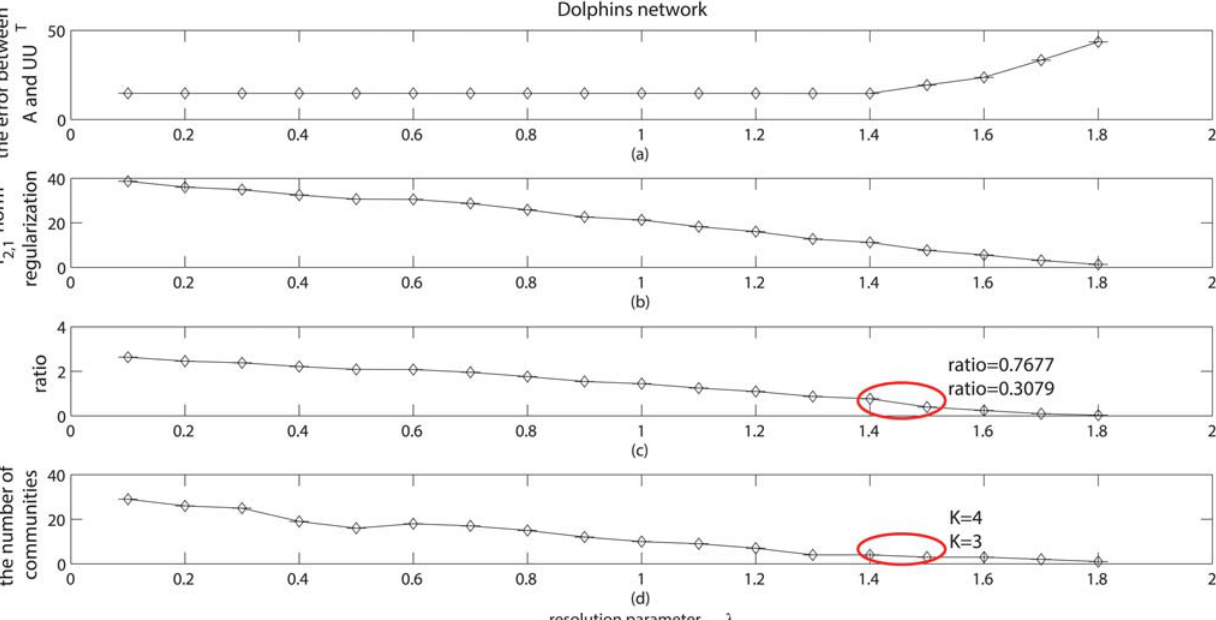
Fig 13. Resolution parameter analysis on dolphins network. (a) shows the error between the adjacency matrix A and the expected adjacency matrix UU T with different resolution parameter λ . (b) shows the value of l 2,1 regularization term with different resolution parameter λ . (c) shows the ratio of l 2,1 regularization term to the error between A and UU T . (d) shows the number of communities with different resolution parameter λ